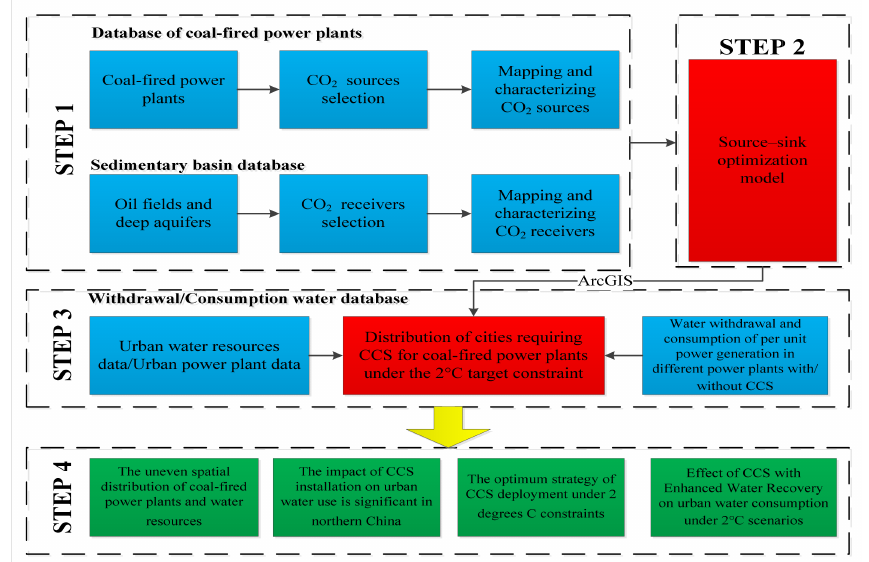
Figure 2. The research framework of this